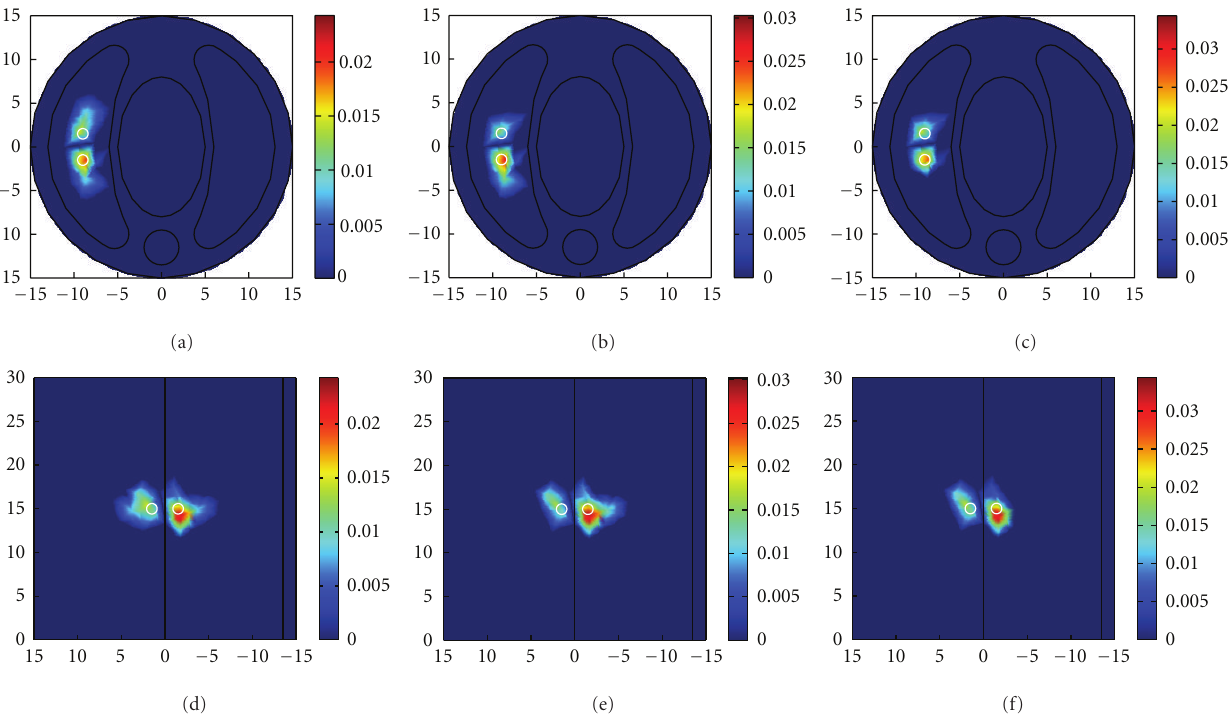
Figure 4: Reconstructed results in double source case under measurement noise level of 20% and system error level of 5%. (a), (b), and (c) separately show the x – y views at z = 15mm plane of the results by Tikhonov + GCV, TTLS + MGCV, and TTLS + IGCV; (d), (e), and (f) are the corresponding y – z views at x = 9 . 5mm plane of the reconstruction results, respectively; the white circle indicates the real source.